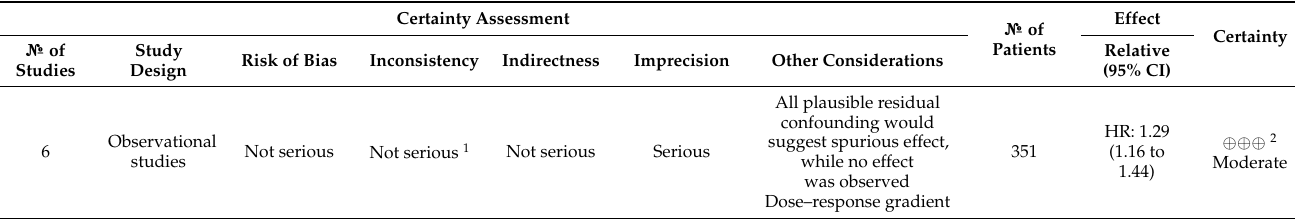
Table 3. Evaluation of GRADE